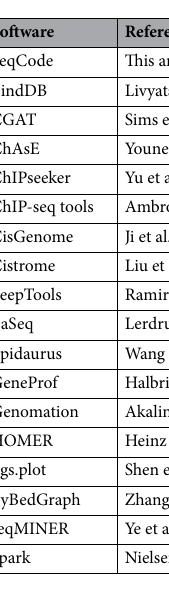
Table 2. List of bioinformatics tools for graphical analysis of sequencing